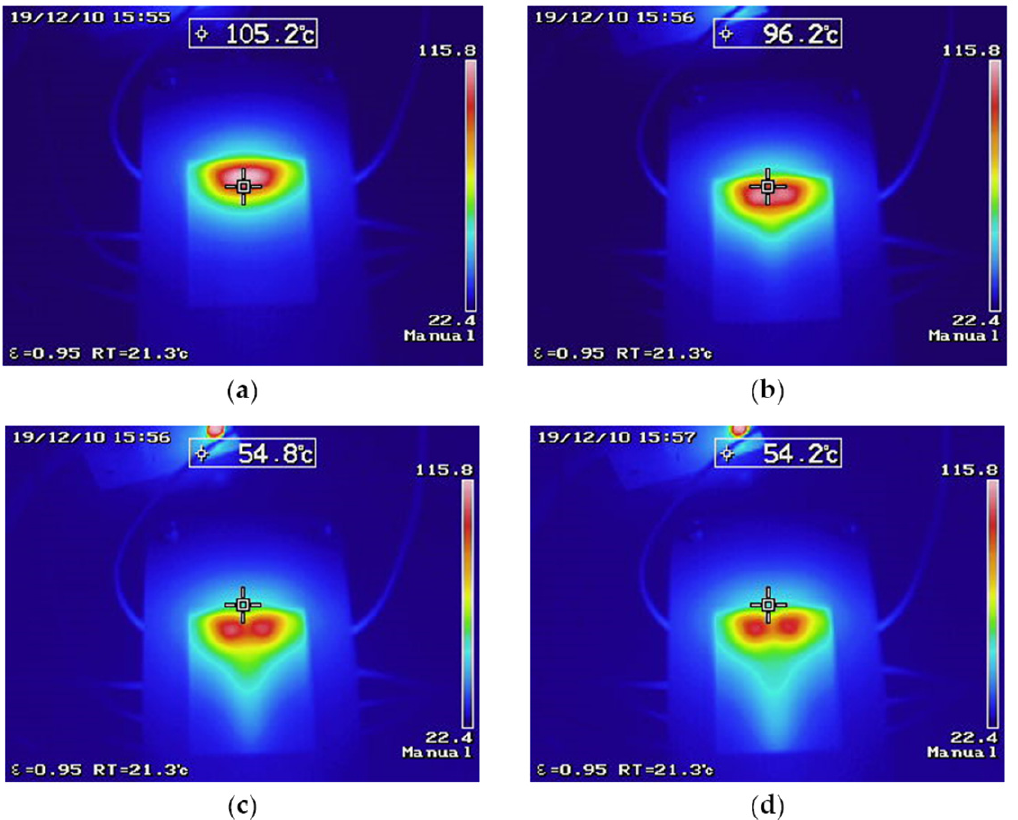
Figure 10. Thermographic camera results in testing with different flows to inspect the heat velocity phenomena: ( a ) 5 mL/h; ( b ) 10 mL/h; ( c ) 15 mL/h; ( d ) 20 mL/h.